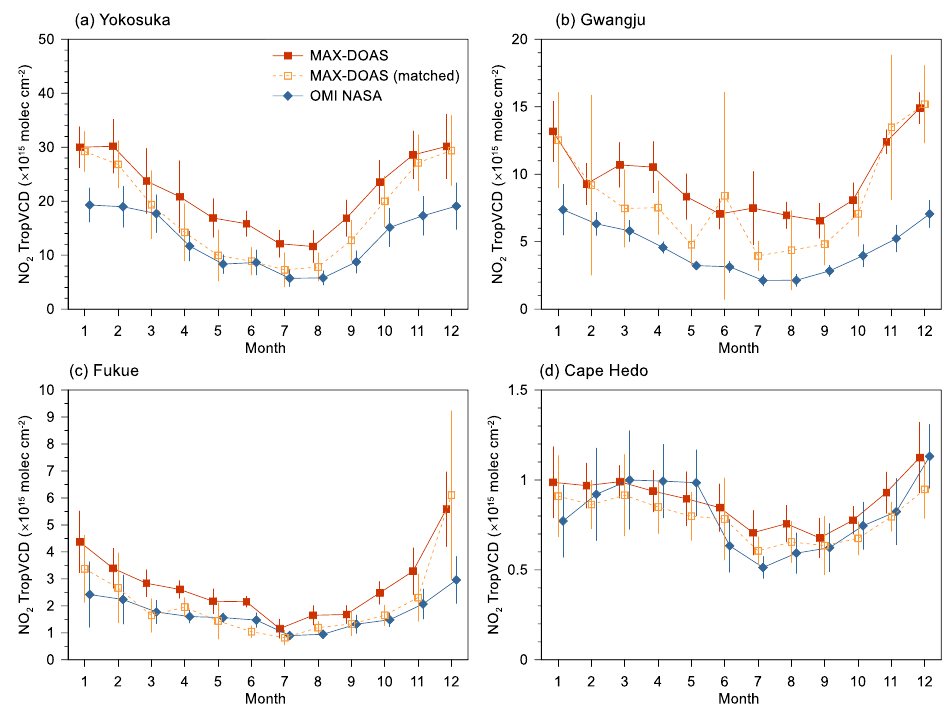
Figure 2. Monthly variation in NO 2 TropVCD from MAX-DOAS and OMI at four sites: ( a ) Yokosuka, ( b ) Gwangju, ( c ) Fukue, and ( d ) Cape Hedo. Red and open orange squares indicate the mean of the whole and time-matched MAX-DOAS data with OMI satellite (blue diamonds) overpass time (~13:30 local time). The vertical bars indicate the monthly standard deviation of NO 2 TropVCD.